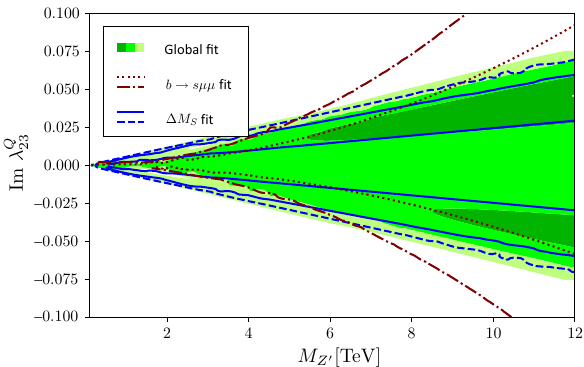
Fig. 3 Fit on Z (cid:2) parameter space in the M Z (cid:2) -Im λ Q ties, both of us obtain a double minimum for the imaginary part ∼ ± ( 1 . 1 − 1 . 2 ) i , again, we obtain a slightly larger pull (5 . 72 σ vs. 4 . 0, 4 . 2 σ of Ref. [34]).